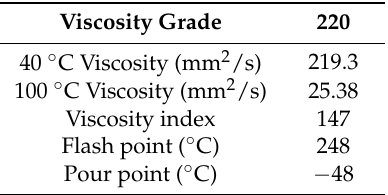
Table 3. Fundamental parameters of both oils.